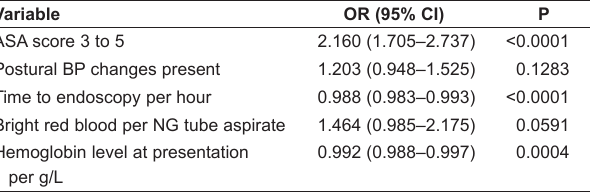
TAble 1 Univariate analysis of clinical and laboratory predictors of high-risk